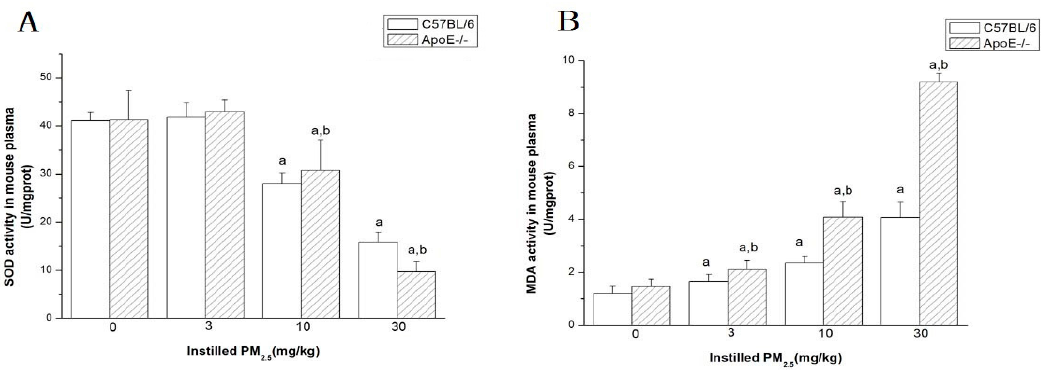
Figure 4. The levels of SOD and MDA in the plasma of mice ( n = 6) after exposed to PM 2.5 .